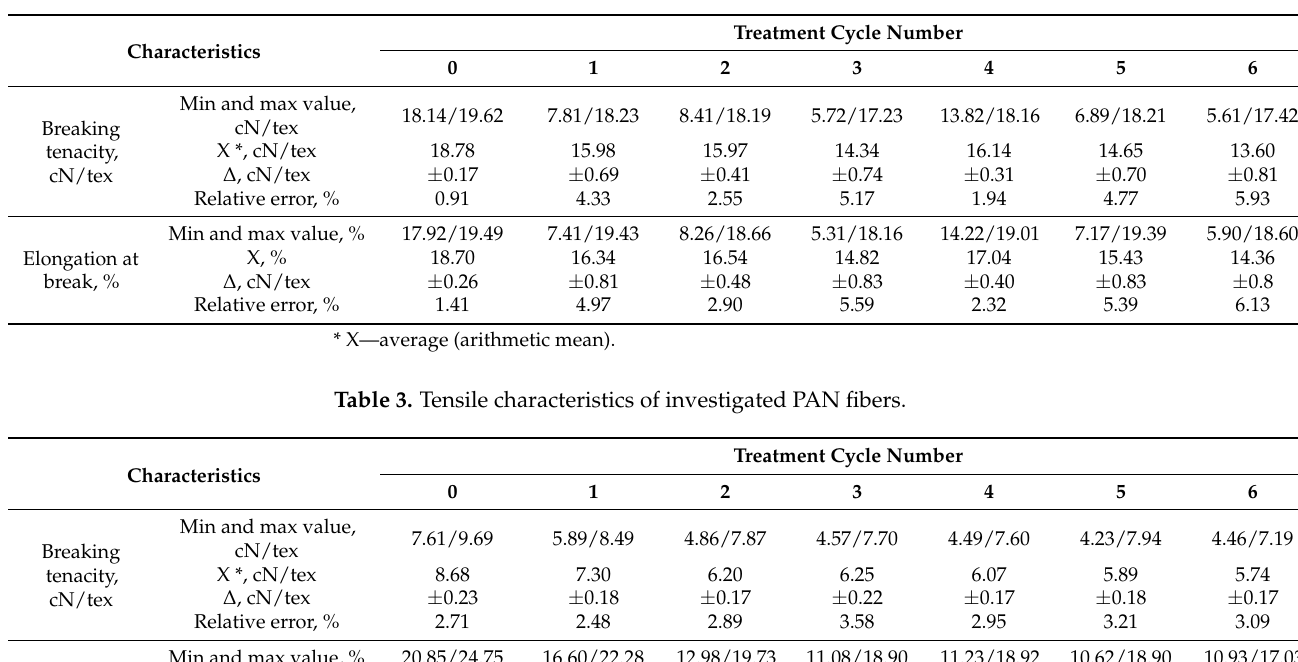
Table 2. Tensile characteristics of investigated PA66 fibers.